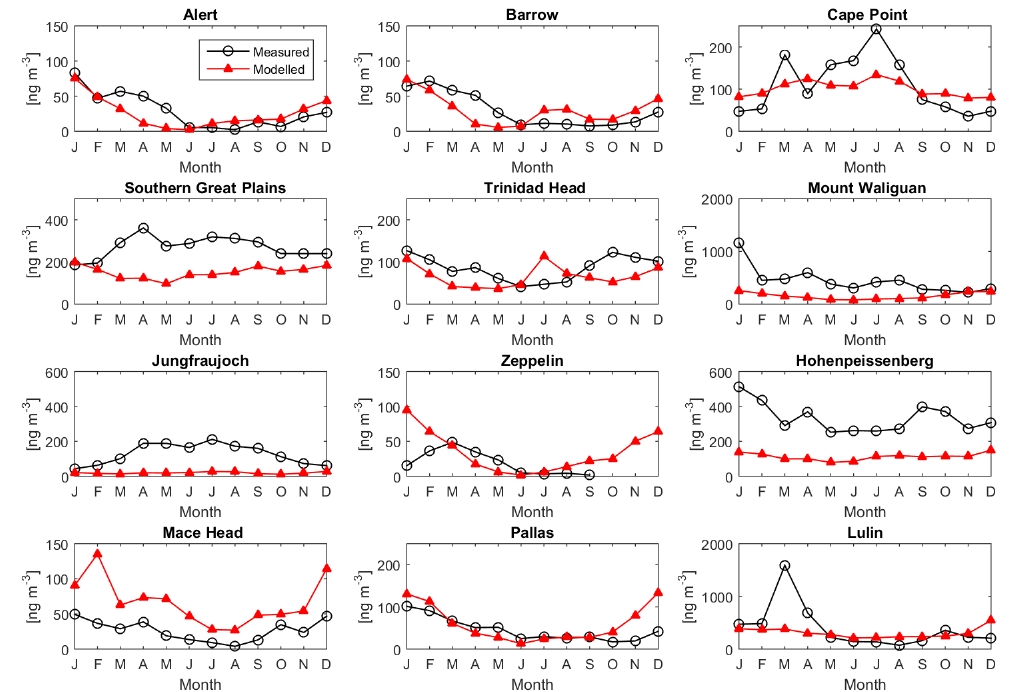
Figure 1. Monthly mean measured EBC versus modeled BC surface concentrations averaged over 2008–2010 (data at Lulin only available for